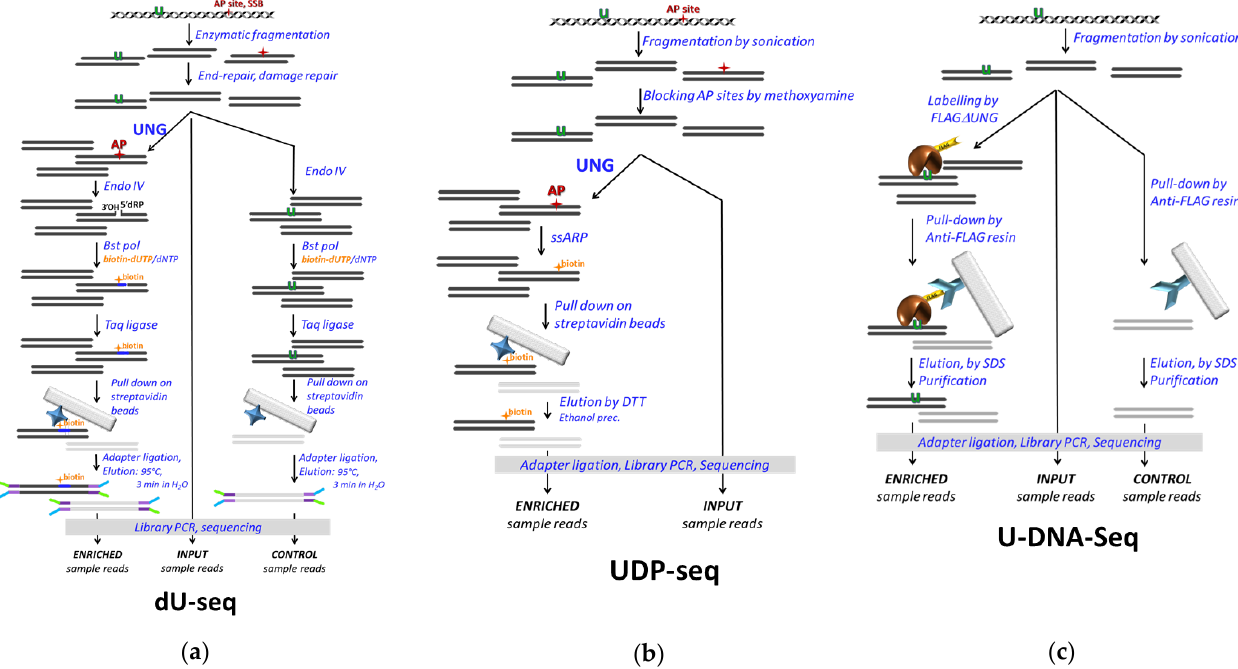
Figure 5. Pull-down-based methods for genome-wide mapping of U-DNA. ( a ) dU-seq. Pre-existing AP sites (red star) and single strand breaks (SSBs) require in vitro repair before the combined UNG/ENDO IV reaction on uracil (green U) containing genomic DNA fragments. Bst polymerase (Bst pol) is used to add nucleotides utilizing biotin-labelled dUTP to the free 3′ -OH end and to remove the 5′ -deoxyribosephosphate ( 5′ dRP). The biotin labelled and re-ligated fragments are pulled down by streptavidin beads. Sequencing results are compared to the control pull-down without UNG treatment. ( b ) UDP-seq. Pre-existing AP sites (red star) are blocked before the UNG treatment. Uracil-related AP sites are chemically labelled by an aldehyde reactive probe (ssARP) conjugated to biotin via a disulfide bridge-containing linker allowing efficient elution by dithiothreitol (DTT) upon pull-down. Sequencing results of pull-down sample is compared to the genomic input. ( c ) U-DNA-Seq. Uracils in genomic DNA fragments are specifically labelled by the FLAG-tagged Δ UNG sensor (FLAG Δ UNG) and pulled down using anti-FLAG agarose. Sequencing results of pull--down sample is compared to the genomic input, and non-specific binding is estimated by a control mock pull-down.